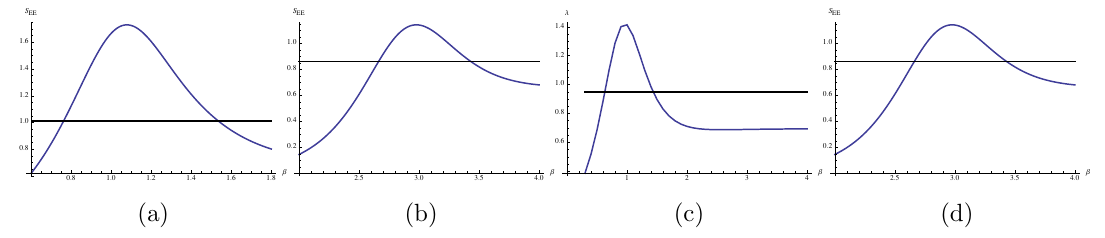
Figure 3. Plots of S EE ( (cid:12) ) for superpositions of Fermi surfaces. The (sub-)system sizes are: (a) L = 8 ; L A = 4, (b) L = 8 ; L A = 3, (c) L = 6 ; L A = 3, and (d) L = 5 ; L A = 2. For each of these cases, S EE of a single Fermi surface (obtained by (cid:12)lling all modes up to k = 6 (cid:25) Note that S EE is greater than that of a single Fermi surface only for a speci(cid:12)c range of (cid:12) .